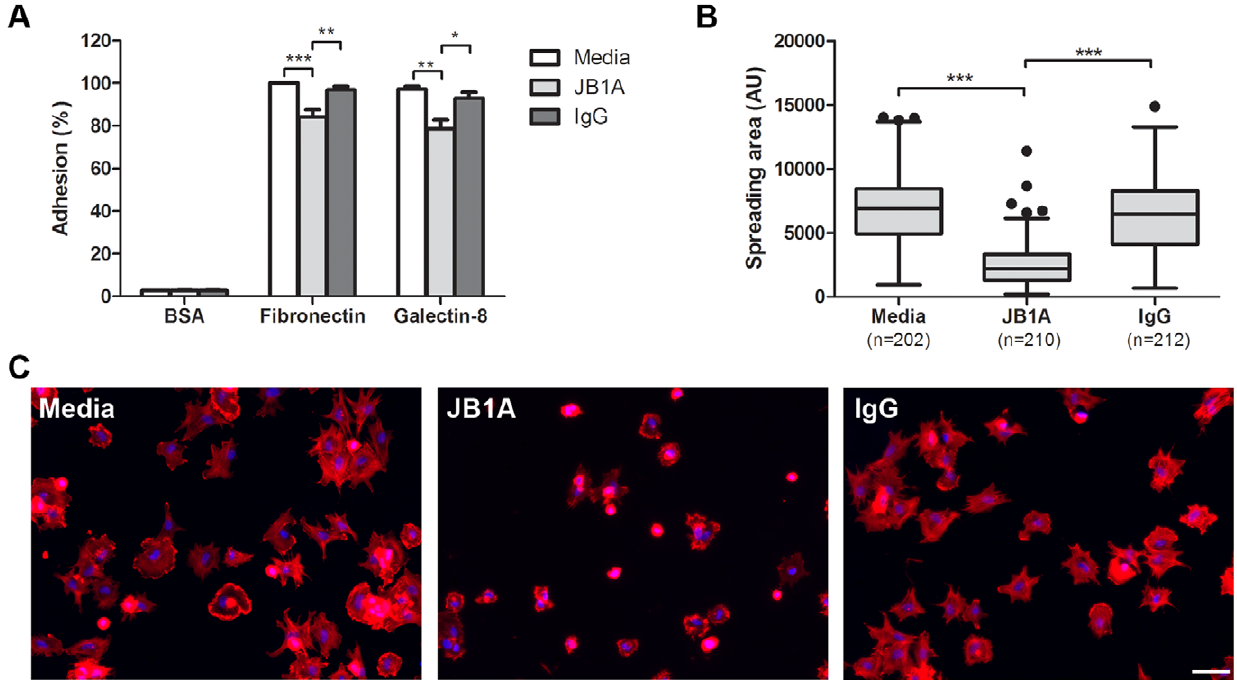
Figure 2. TM cell adhesion and spreading on Gal8 is mediated by b 1 integrins. A: Normal human TM cells were incubated on microtiter wells coated with BSA, fibronectin, or Gal8 in DPBS, in the presence and absence of a function-blocking anti- b 1 integrin antibody (JB1A), or control mouse IgG. Following incubation at 37 u C for 30 min, cells were fixed and stained with crystal violet. Attached cells in fibronectin-coated wells are set as 100% (positive control); attached cells in other wells are presented as percent of positive control. Data are expressed as mean 6 SEM and analyzed with one-way ANOVA. * P , 0.05 vs IgG; ** P , 0.01 vs media or IgG; *** P , 0.001 vs media. B and C: Cell spreading assay. TM cells were fixed with 4% paraformaldehyde after adhesion for 30 min. F-actin was stained with rhodamine-labeled phalloidin and cell nuclei were labeled with DAPI. Random fields of each experimental condition were photographed, and spread areas of individual cells were quantified with ImageJ. Representative micrographs of TM cells incubated in the presence and the absence of anti- b 1 integrin antibody are shown in C. Data are presented as Box–whisker plot (after Tukey) and analyzed with one-way ANOVA. *** P , 0.001 vs media or IgG. This experiment was performed three times with reproducible results. Bar: 100 m